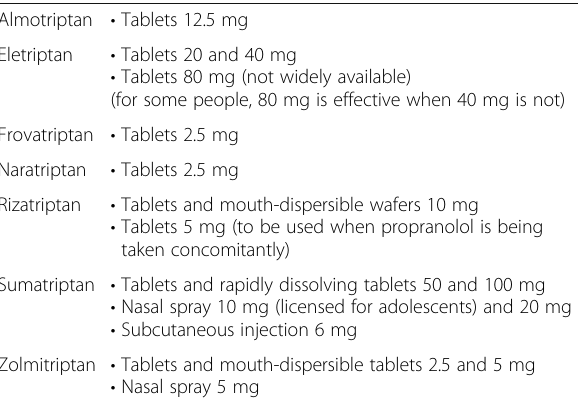
Table 8 Specific anti-migraine drugs, formulations and doses for step two (listed